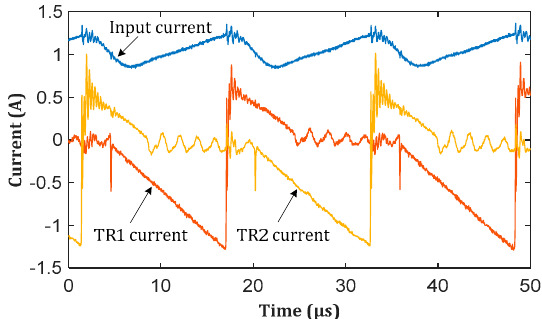
Figure 19. Experimental waveforms of two interleaved transformer currents forming continuous input current (P = 200 W). Energies 2019 , 12 , x FOR PEER REVIEW